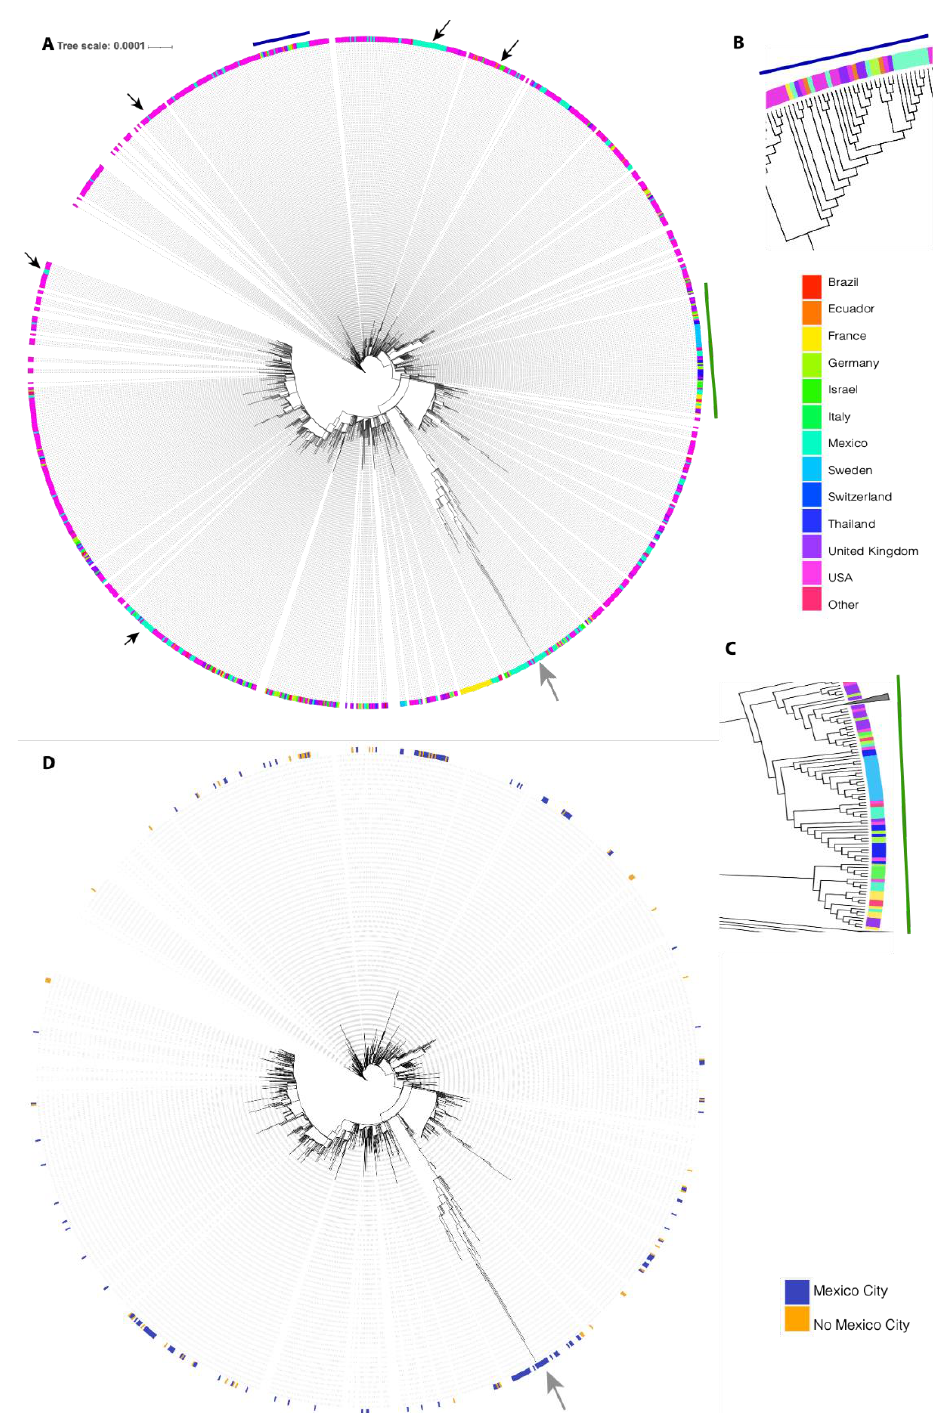
Figure 1. The best-scoring ML phylogeny of Omicron SARS-CoV-2 samples collected in Mexico together with their closest worldwide relatives. ( A ) The best-scoring ML phylogeny of all sequences is presented. Black arrows indicate exchange events between the USA and Mexico. The gray arrow displays a group of sequences collected in Mexico that have largely diverged from the rest of the sequences. ( B ) A zoom on the region indicated by the blue line. ( C ) A zoom on the region indicated by the green line. Colors represent countries in which the analyzed sequences were collected. ( D ) Blue represents sequences collected in Mexico City; orange represents sequences collected in Mexico but not in Mexico City.